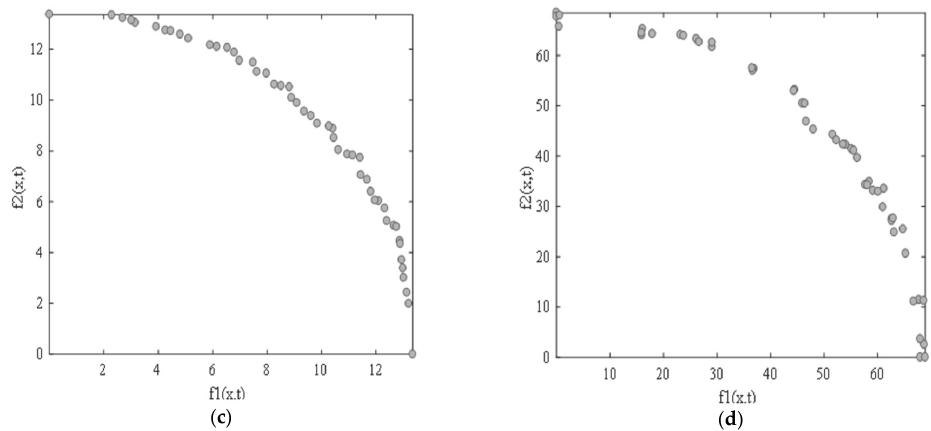
Figure 5. Two-objective PF for ( a ) Case 1, ( b ) Case 2, ( c ) Case 3, ( d ) Case 4.